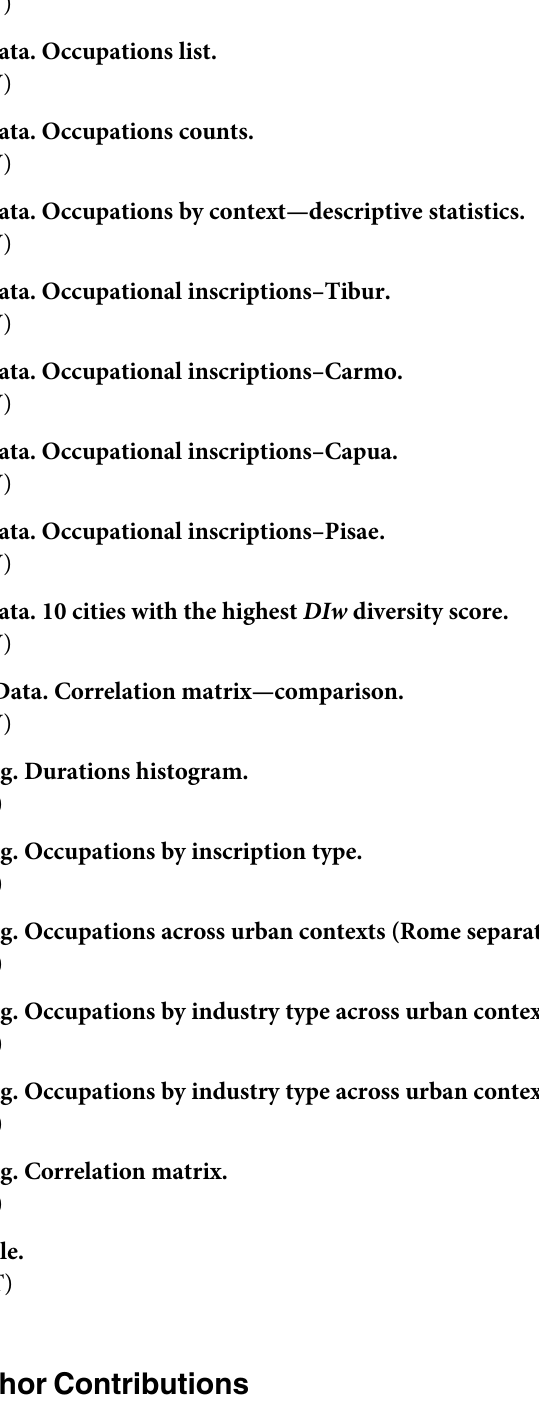
S1 Fig. Durations histogram. S2 Fig. Occupations by inscription type. S3 Fig. Occupations across urban contexts (Rome separately). S4 Fig. Occupations by industry type across urban contexts (Rome separately). S5 Fig. Occupations by industry type across urban contexts (HISCO). S6 Fig. Correlation